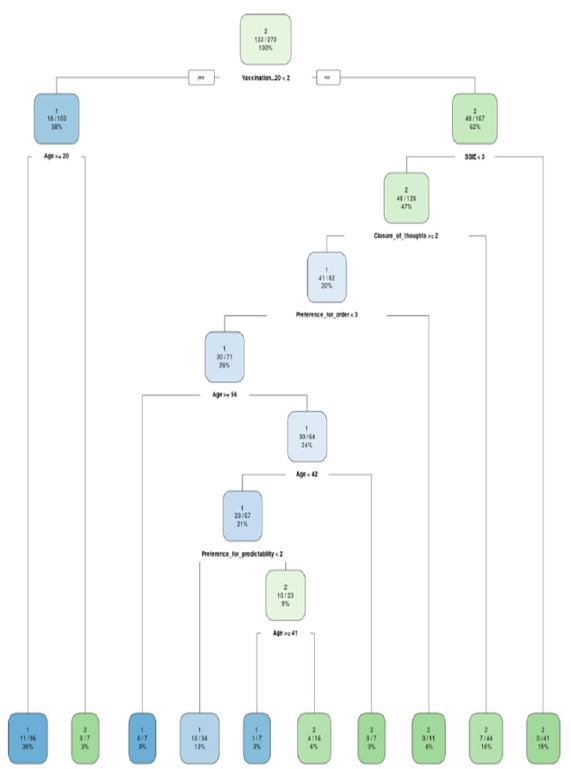
Figure 3. Classification model for a stay in the public transportation: 1—wearing a mask; 2—not wearing a mask.